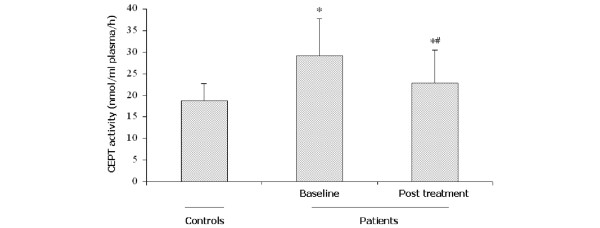
Cholesterol ester transfer protein (CETP) activity of controls and early rheumatoid arthritis patients before and after therapy. Data are expressed as means ± standard deviation. *p < 0.001 compared with controls; #p < 0.05 compared with pretreatment values.